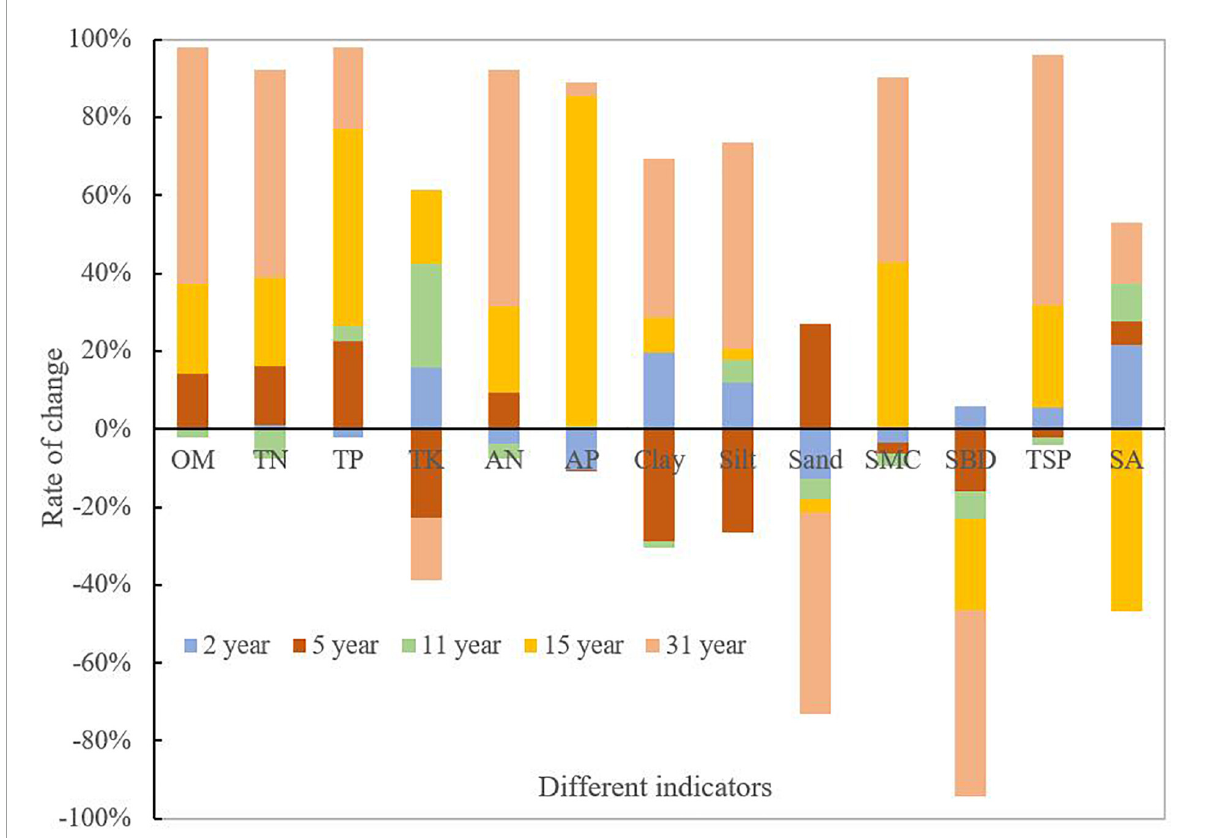
FIGURE4 Changes of the soil physical and chemical properties in different years of afforestation and natural state plots in the same region.